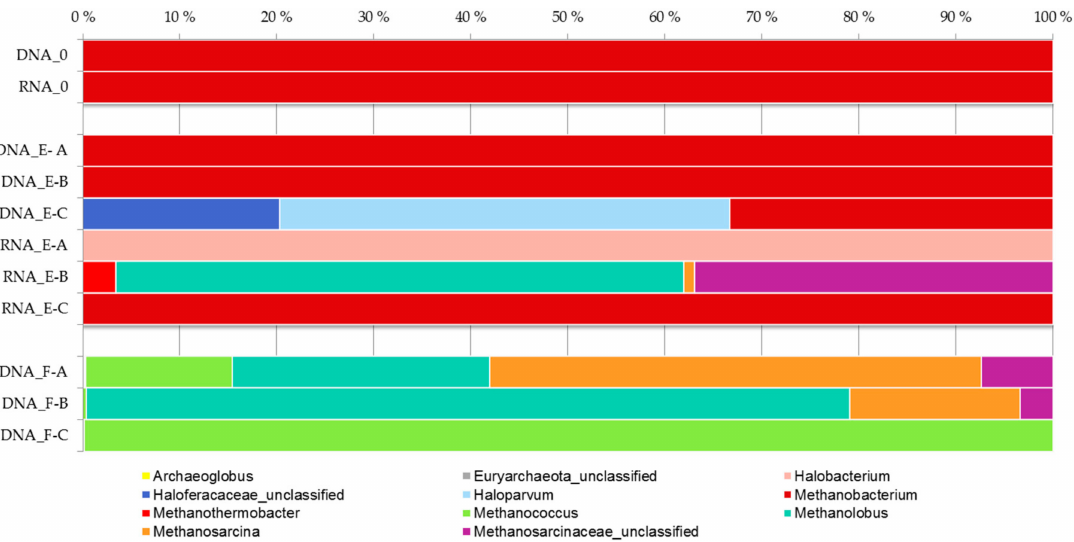
Figure 3. Taxonomy of archaeal 16S rRNA gene OTUs. Samples representing the original fracture fluid: DNA_0 and RNA_0, enriched samples representing the communities in the incubated microcosms DNA_E—samples A, B, C (DNA) and RNA_E—samples A, B, C (RNA) and the labelled fractions: DNA_F—samples A, B, C (DNA-SIP); X -axis visualizes the detected genera (percentage of total number of sequences detected) and Y -axis illustrates the sample